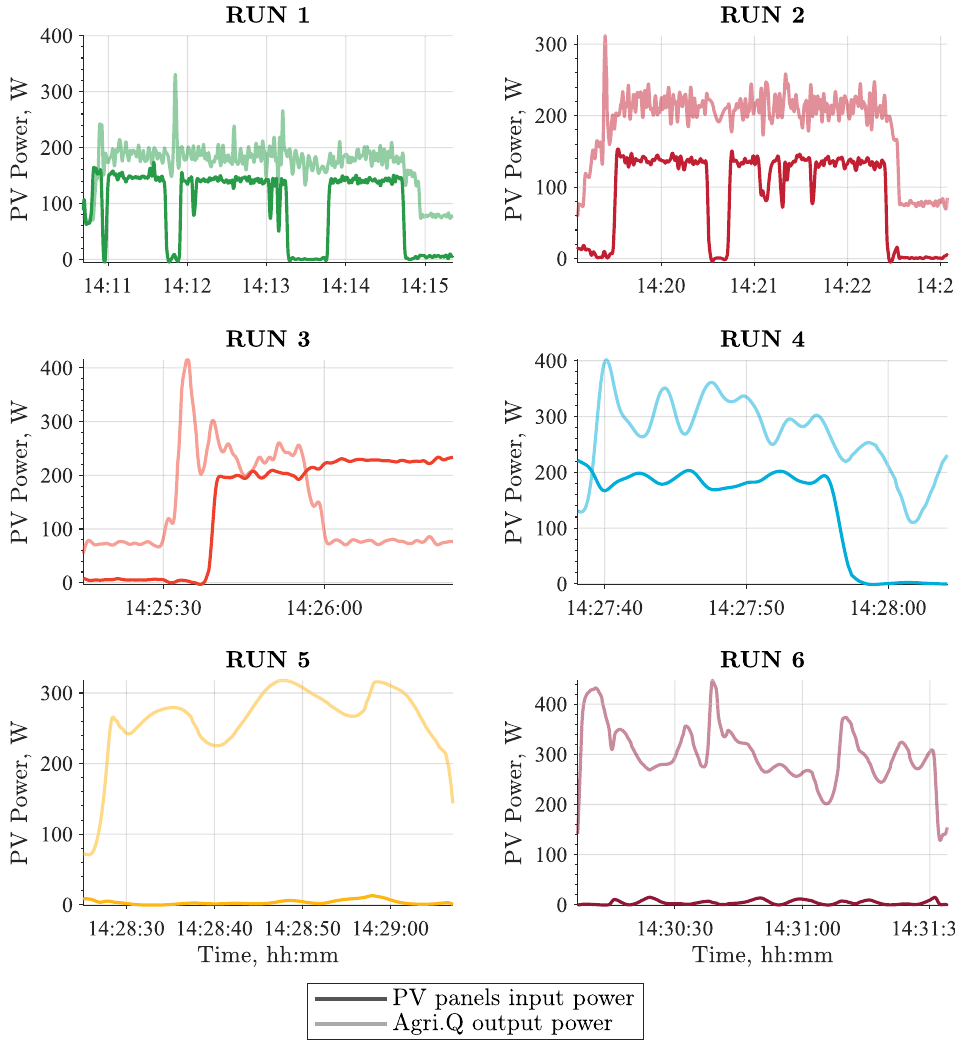
Fig. 12 Navigation tests power balance. Run 1: FWD on a paved surface; Run 2: AWD on a paved surface; Run 3: FWD on a flat grass field; Run 4: AWD on a flat grass field; Run 5: AWD circular trajectory on a paved surface; Run 6: AWD circular trajectory on a flat grass